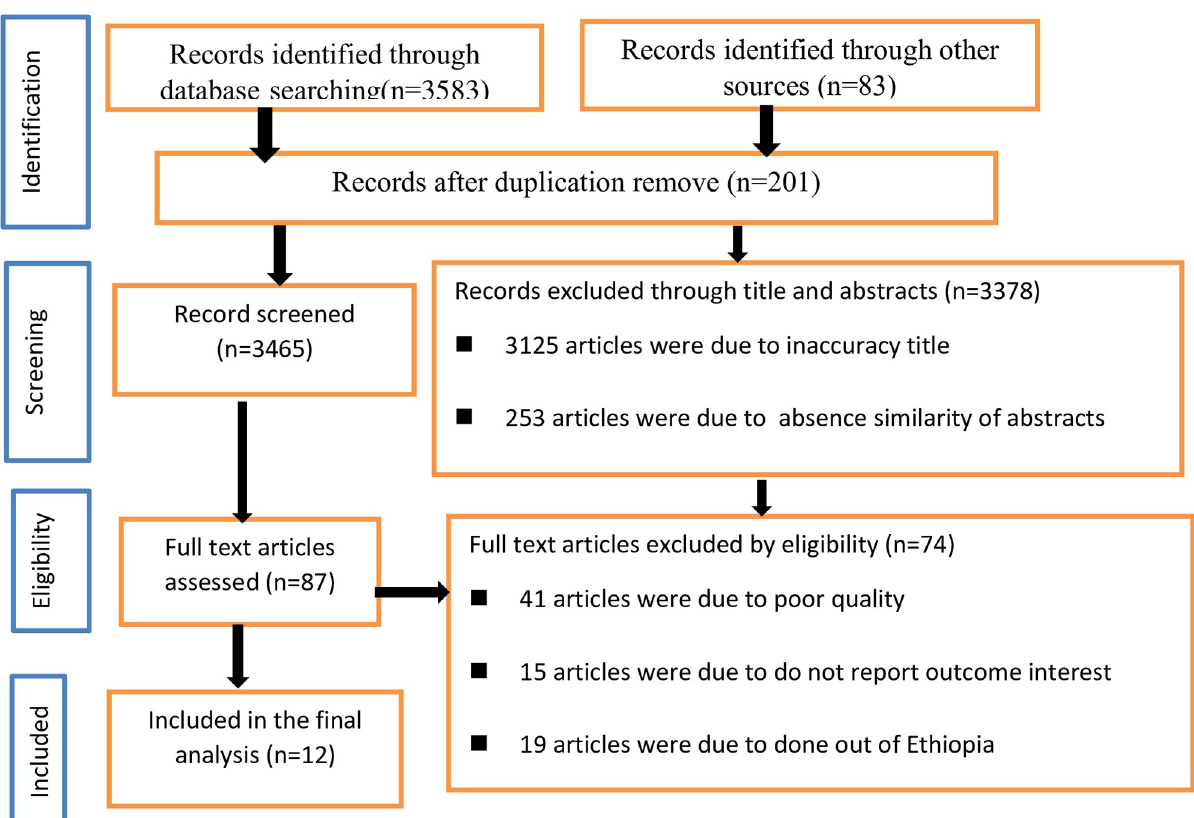
Fig 1. PRISMA diagram of selecting and including studies for a systematic review and meta-analysis for the prevalence of health-related quality of life of cancer patients in Ethiopia, 2021.